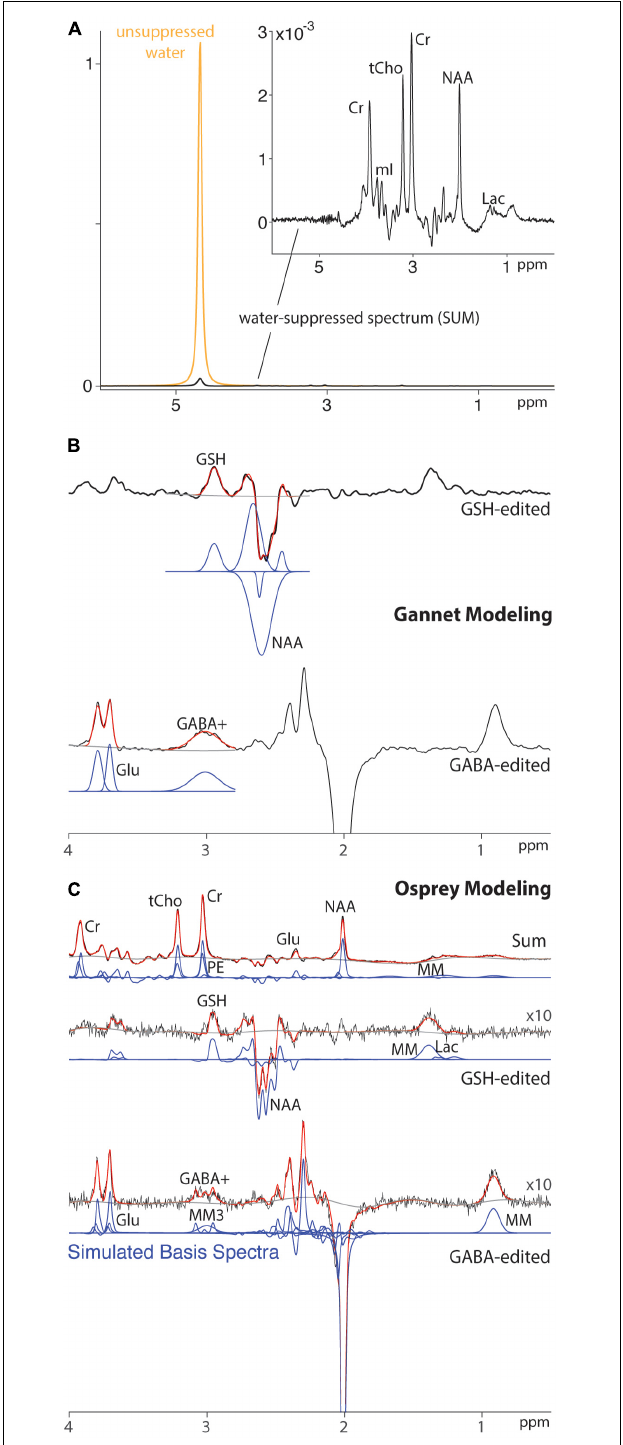
FIGURE 1 | Modeling of HERMES data for a single subject using peak fitting and LCM. (A) Spectra acquired without (gold) and with (black) water suppression. (B) Peak fitting of water-suppressed HERMES data using Gannet. (C) LCM of water-suppressed HERMES data using Osprey. Black line: water-suppressed data. Red line: model. Gray line: baseline. Blue line: basis